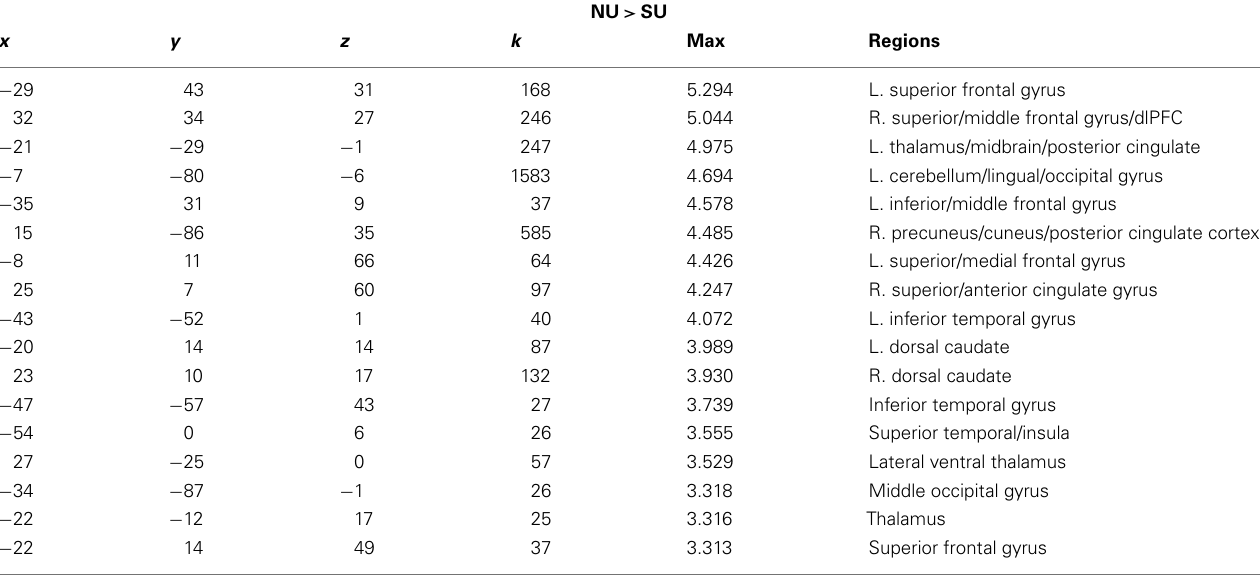
Table 7 | x , y , z coordinates, max activation, and cluster size for the contrast of non-using > substance-using mothers for the pure